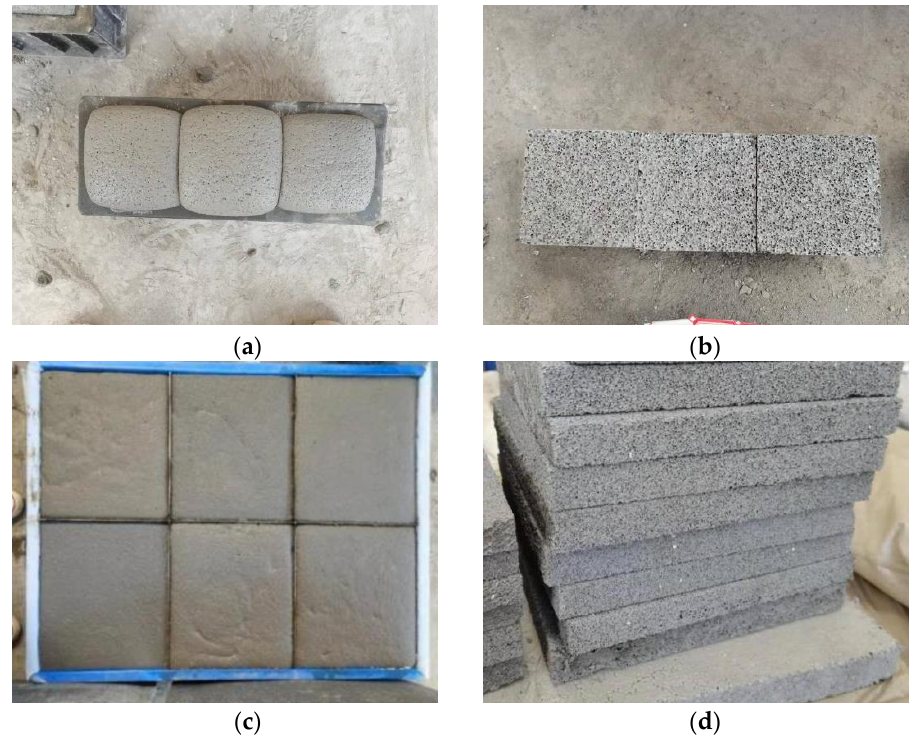
Figure 1. Fly ash foam concrete test block. ( a ) Test block preparation. ( b ) Test block handling. ( c ) Test block preparation. ( d ) Test block handling.